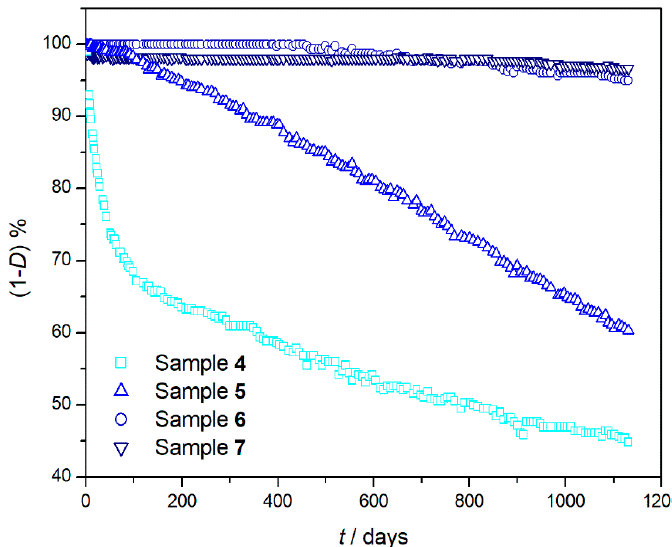
Figure 3. Percentage of undegraded sample (1 − D )% at 150 °C as a function of heating time ( t ) for PE (sample 4 ), PS (sample 5 ), PC (sample 6 ), and PMMA (sample 7 σ ) after 1130 days of degradation.